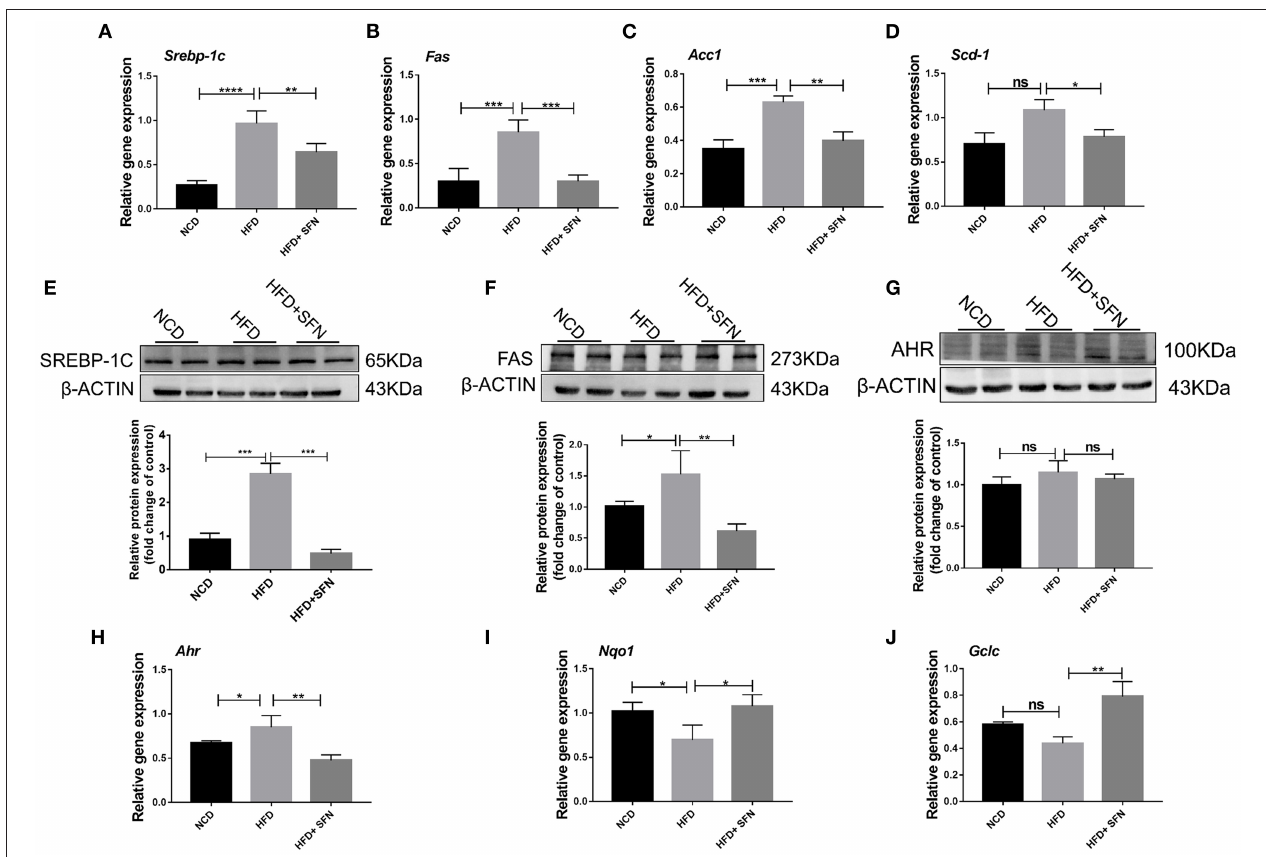
FIGURE 2 | Effects of SFN on lipid metabolism of the liver. (A–D) Relative mRNA levels of Srebp-1c , Fas , Acc1 and Scd-1 were associated with de novo lipogenesis in the liver. (E,F) Western blot showing SREBP-1C and FAS protein levels in the liver. (G) Levels of total AHR protein in the liver. (H) The expression of Ahr in the liver tissue. (I,J) Antioxidant stress relative gene expression in the liver. Data are presented as mean ± SD. ns, not significant, * P < 0.05, ** P < 0.01, *** P < 0.001, **** P < 0.0001 vs. HFD group.